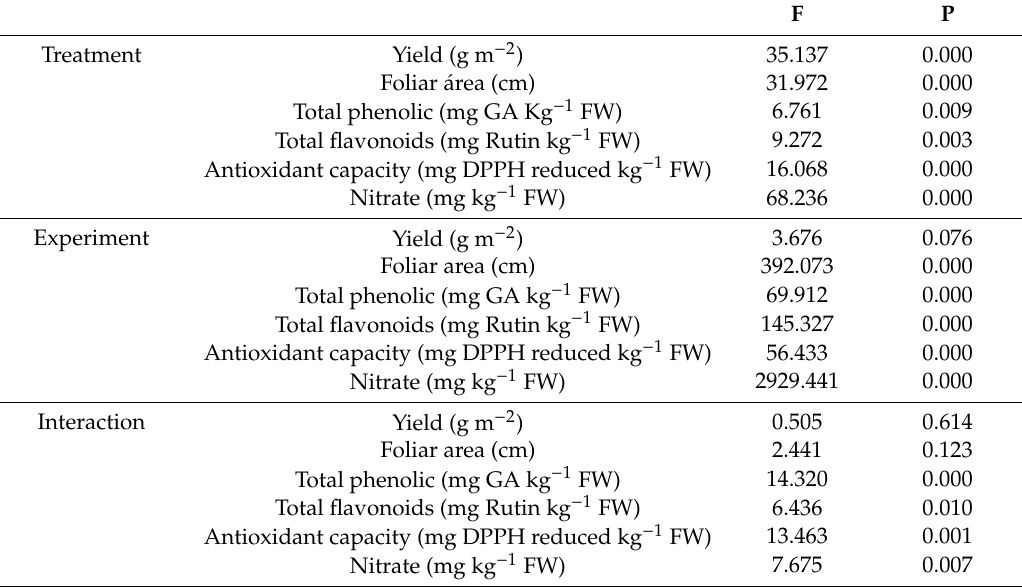
Table 2. Influence of di ff erent CT treatments on yield, foliar area, total phenolic, total flavonoids, antioxidant capacity and nitrate content in both experiments (early winter and late